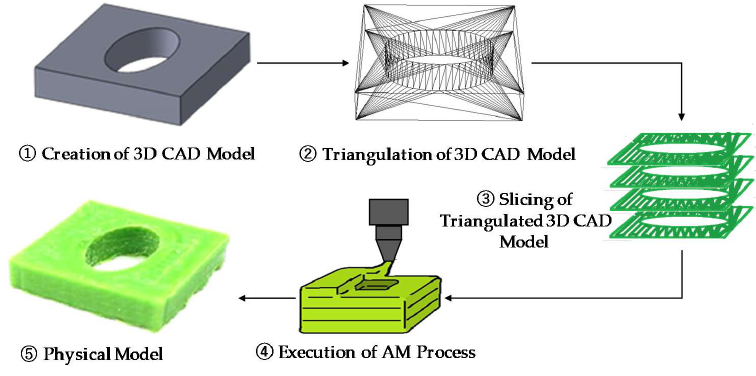
Figure 1. The working principle of Additive Manufacturing (AM).